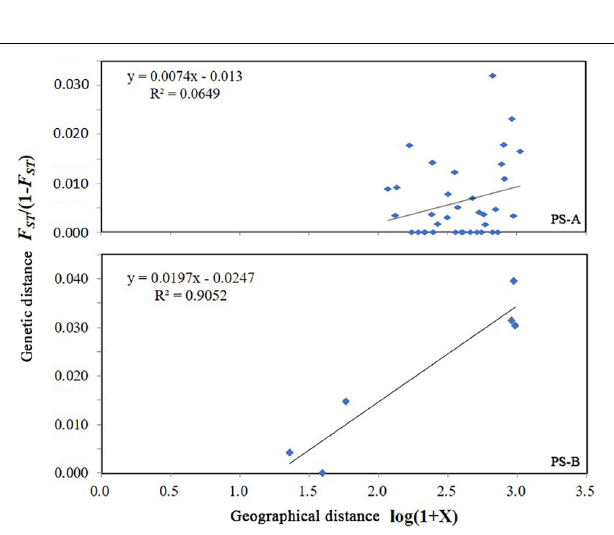
FIGURE 7 | Results of Mantel tests of genetic distance vs. geographical distance of the populations of Parantica sita lineages: PS-A and PS-B.